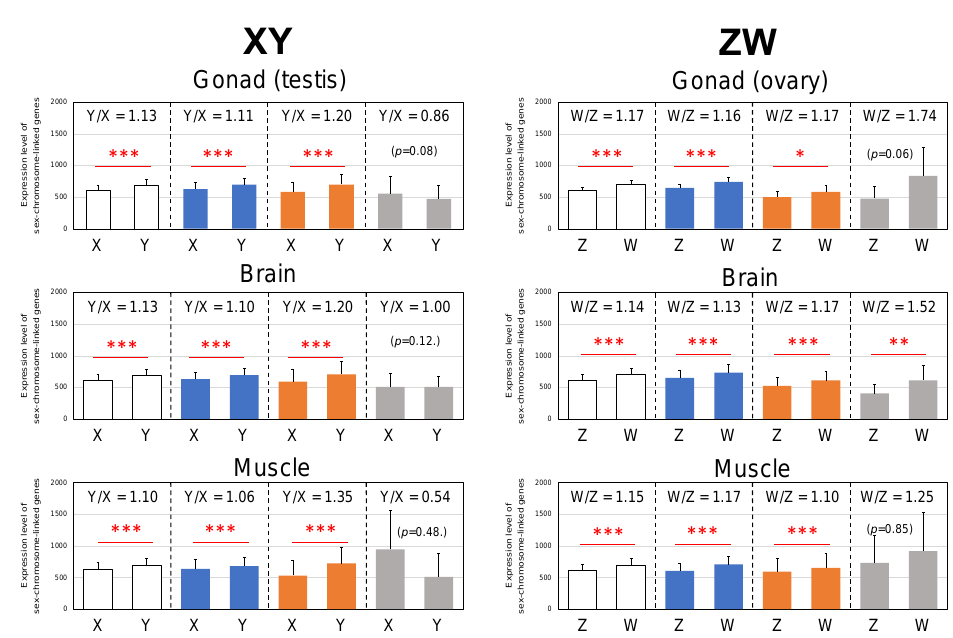
Figure 6. Allelic expression of the sex chromosome linked genes. Statistical analysis of the expression ratio of the sex-linked genes between the sex chromosomes were performed using the Wilcoxon– Mann–Whitney tests (paired). *, **, *** are p < 0.05, p < 0.01, and p < 0.001, respectively. The abbreviations are the same as in Figures 2 and 4.